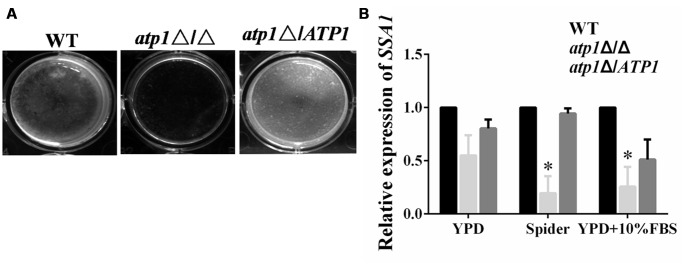
Deletion of ATP1 displays defective adhesion and invasion. (A) Effect of ATP1 on C. albicans adhesion. 1 × 107 cells suspension of C. albicans in spider media was added to 24-well flat bottomed plates and incubated for 24 hours at 37°C. The wells were washed with PBS and taken photos. (B) Effect of ATP1 on the expression of C. albicans adhesion gene. Effect of ATP1 on the expression of C. albicans invasion gene. C. albicans cells were incubated in YPD, Spider, YPD+10%FBS media at 37°C for 6 h. Following incubation expression of the indicated genes were determined by qRT-PCR. Expression level of each gene is displayed after normalization with internal control housekeeping gene 18S. The histogram shows the relative expression fold change of genes. Results represent the average of three independent experiments ±SD. ∗P < 0.05 when compared with WT.